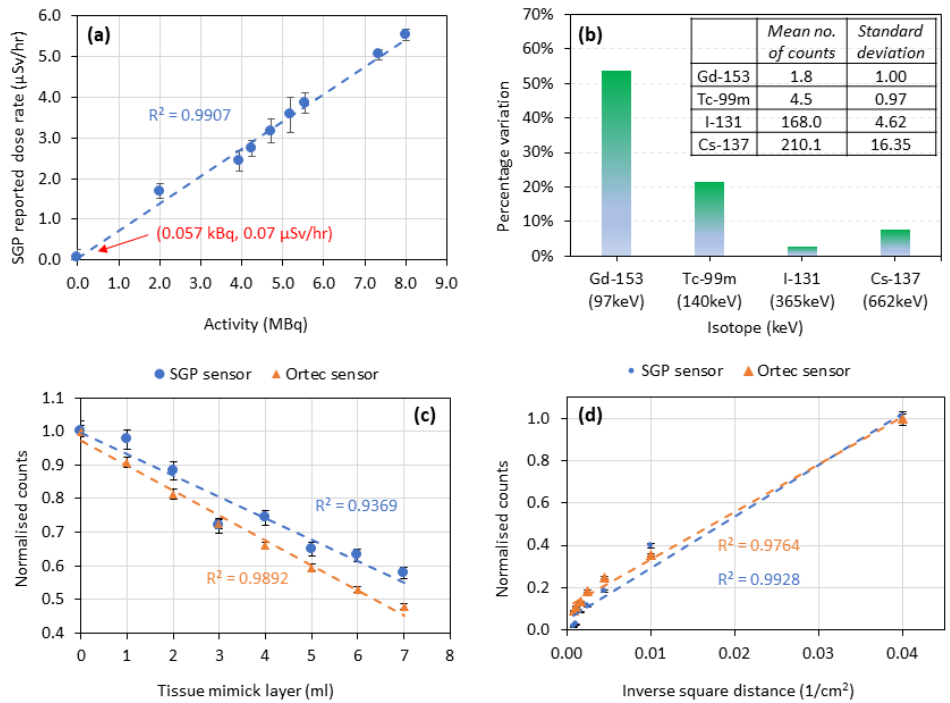
Figure 2. ( a ) SGP-reported dose rate ( µ Sv/hr) vs. activity (MBq) for an I-131 capsule, measured using the SGP sensor. Dashed line represents a linear fit of the data (R 2 value = 0.9907), and the data point indicated by the red arrow is the lowest I-131 activity detectable by the SGP sensor; ( b ) Coefficient of variation obtained from 10 measurements of the number of counts for different isotopes with various principal gamma energies (keV). Inserted table shows the mean number of counts and standard deviation for each isotope; ( c ) Normalised counts vs. tissue mimick layer/thickness (mL), measured using both the SGP and standard thyroid uptake (Ortec) sensors. Dashed lines represent linear fits of the data (R SGP2 = 0.9369. R Ortec2 = 0.9892); ( d ) Normalized counts vs. inverse squared distance (1/cm 2 ) from the source of I-131, measured using both the SGP and standard thyroid uptake (Ortec) sensors. Dashed lines represent linear fits of the data (R SGP2 = 0.9764 and R Ortec2 = 0.9928). The error bars on all data points represent the standard deviation of three independent measurements.